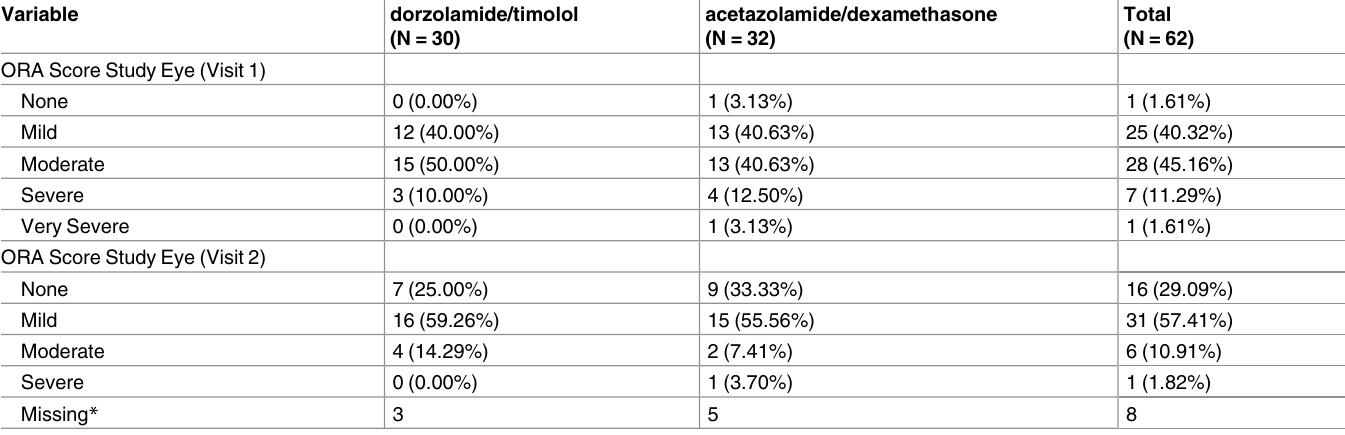
Table 6. Grading of conjunctiva—ITT population (N = 62).